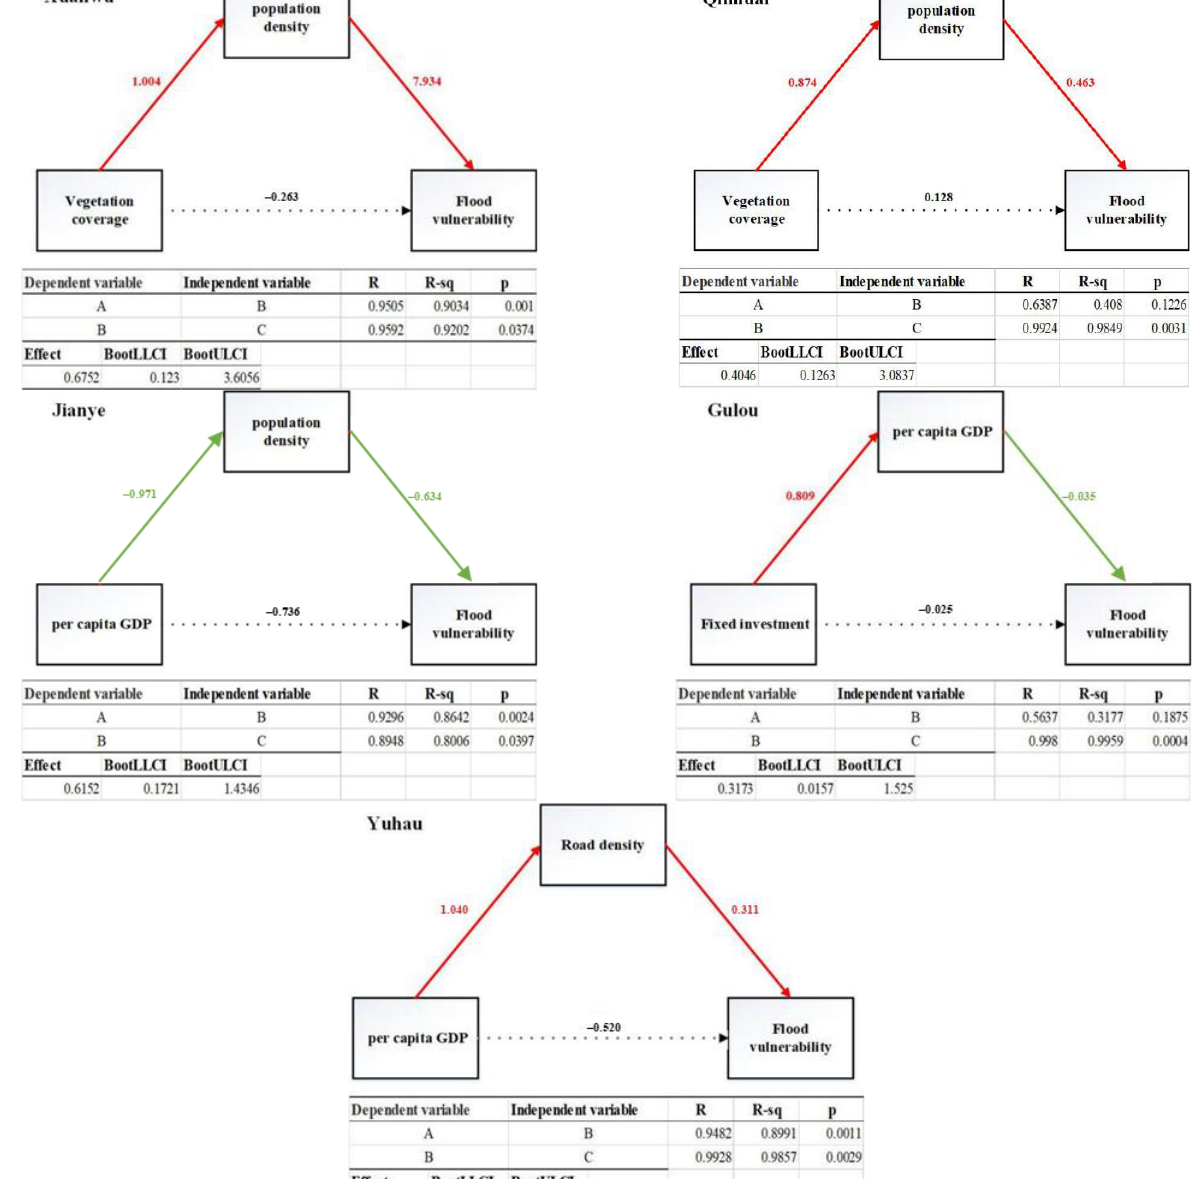
Figure 6. The path models of the five districts.